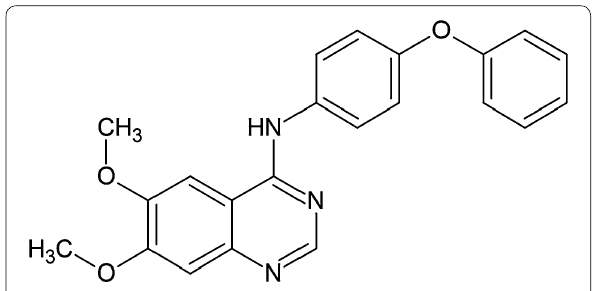
Fig. 1 Chemical structure of APS-1-68-2, a quinazoline heterocycle with attached biphenyl ether group [14]. (This figure is republished with permission from both the Nature Publishing Group and Dr. Arvin